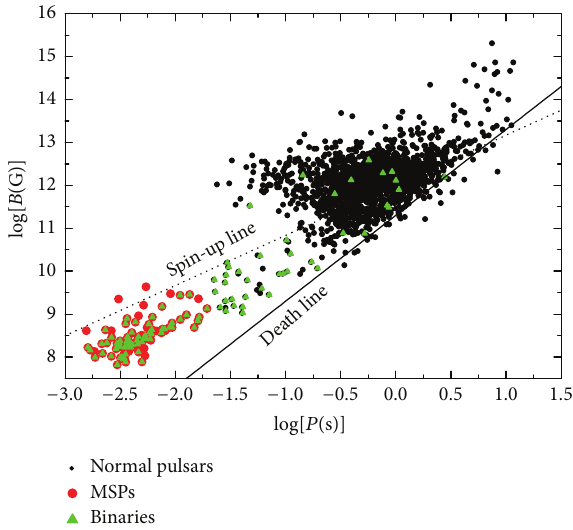
Figure 2: Magnetic fields and spin periods of observed pulsars (data taken from the ATNF pulsar catalogue). Black dots denote normal pulsars. Red dots represent MSPs. Green triangles are pulsars in binaries. The “spin-up line” represents the minimum spin period to which a spin-up process may proceed in an Eddington-limited accretion, while the “death line” corresponds to a polar cap voltage below which the pulsar activity is likely to switch off